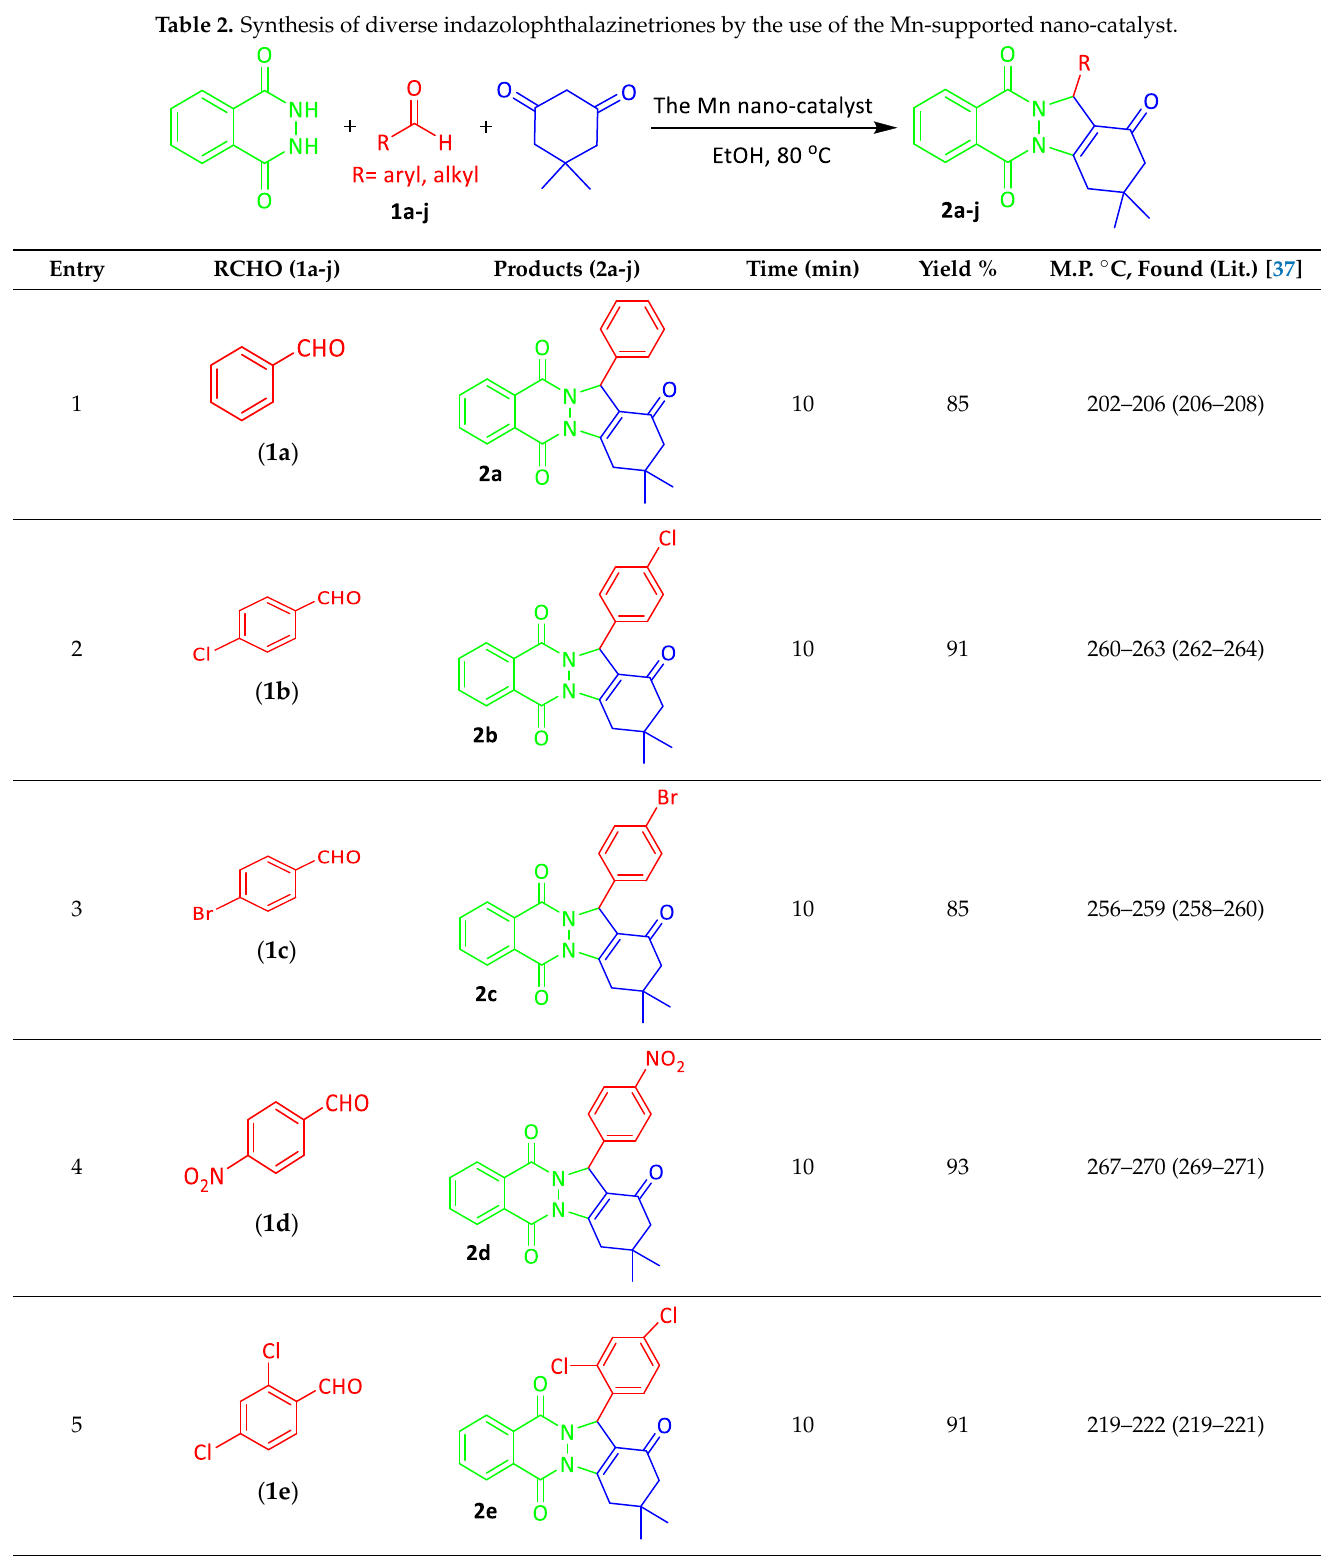
Table 2. Synthesis of diverse indazolophthalazinetriones by the use of the Mn-supported nano-catalyst.